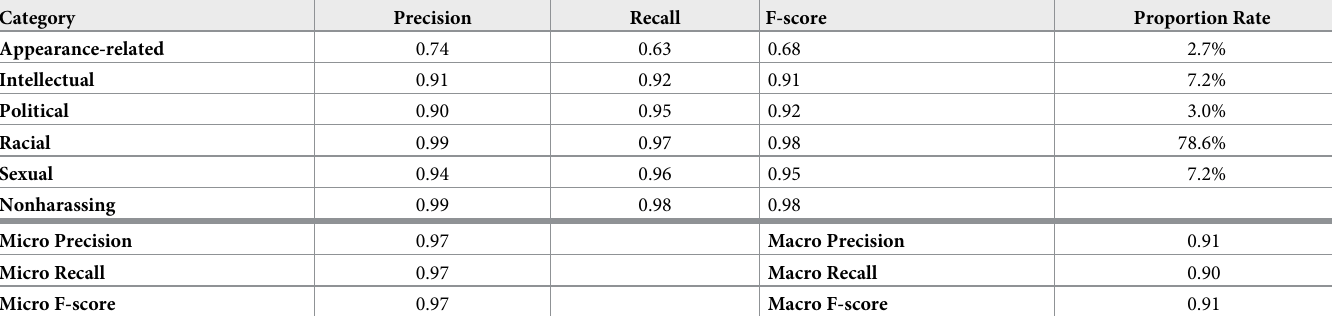
Table 9. Performance of our classifier for predicting tweets for Golbeck